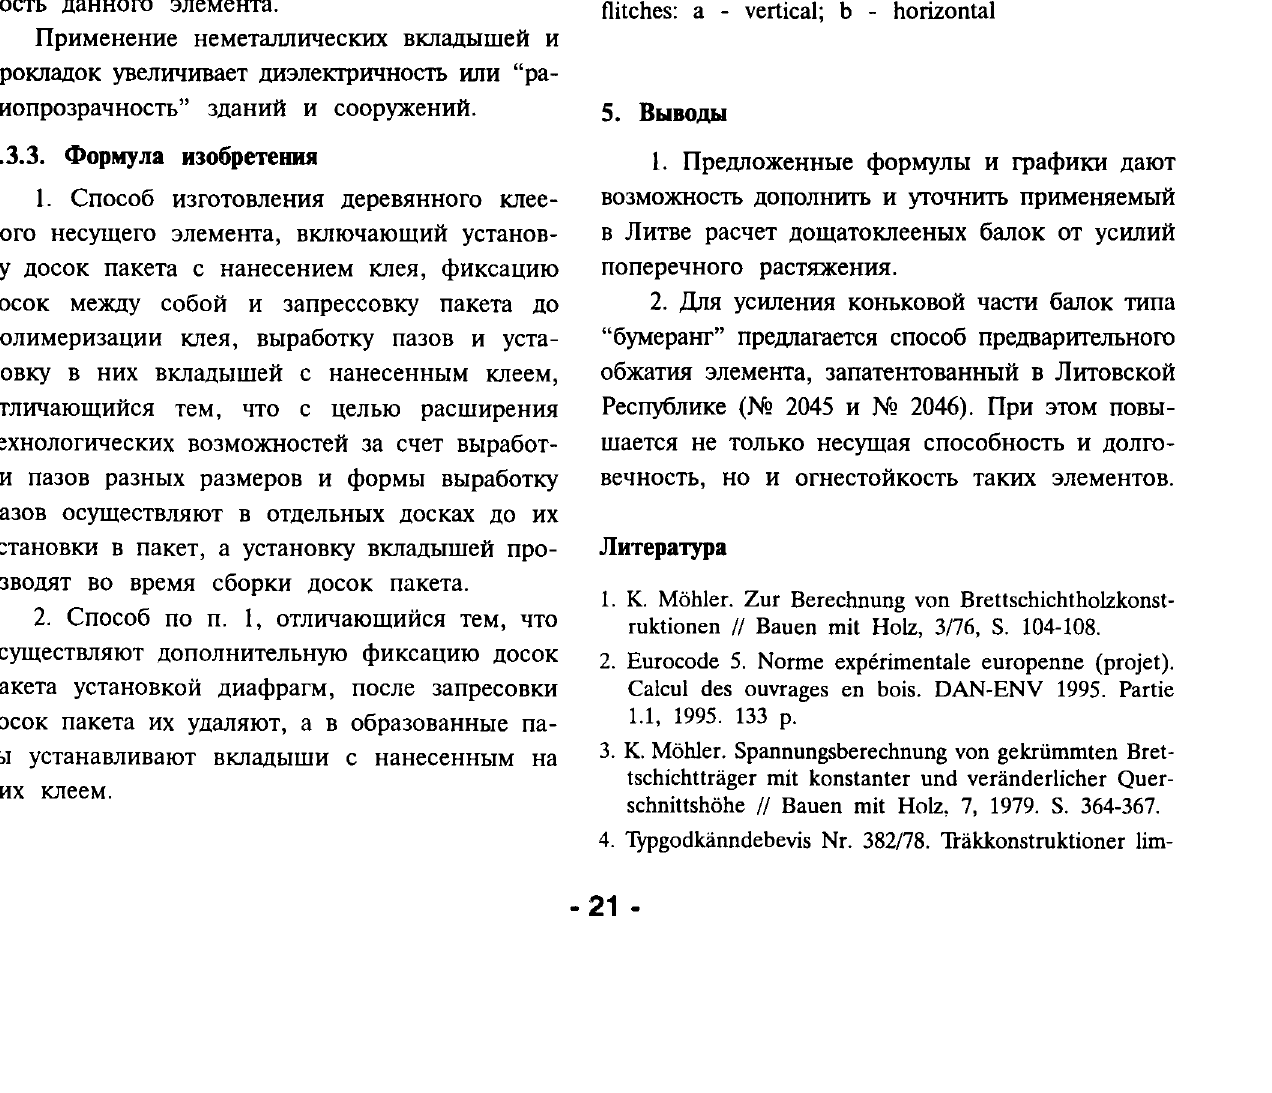
Fig 10. Distribution of year layers of timber in the flitches: a - vertical; b -